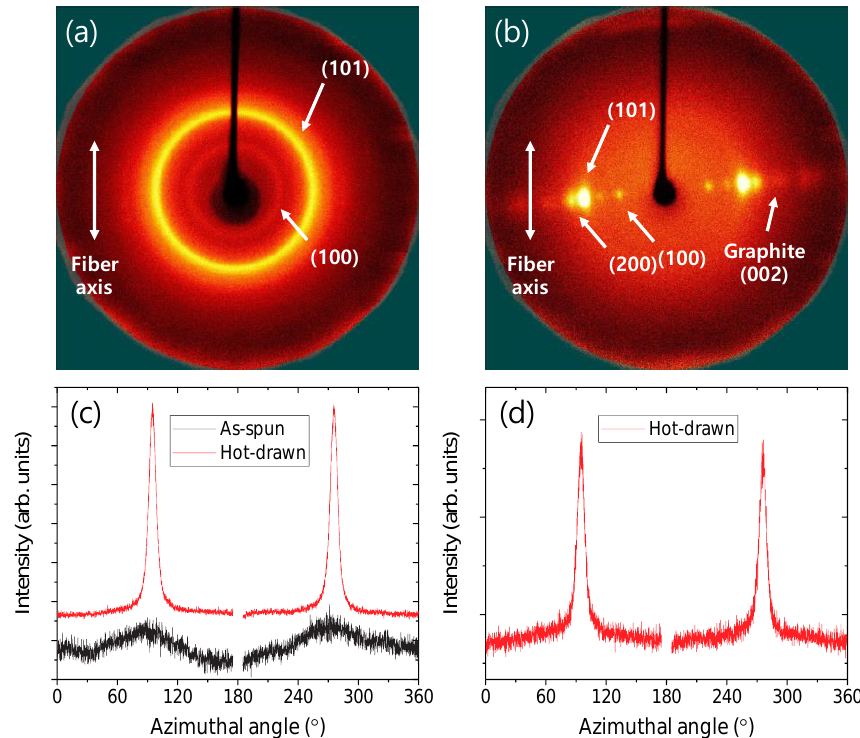
Figure 4. Two-dimensional wide-angle X-ray scattering patterns of ( a ) as-spun ( a ) and ( b ) hot-drawn polyvinyl alcohol/(3.0 wt%) edge-selectively oxidized graphene composite fibers and their angular scattered intensity at 2θ of ( c ) 19°–23° and ( d ) 26°–27°.